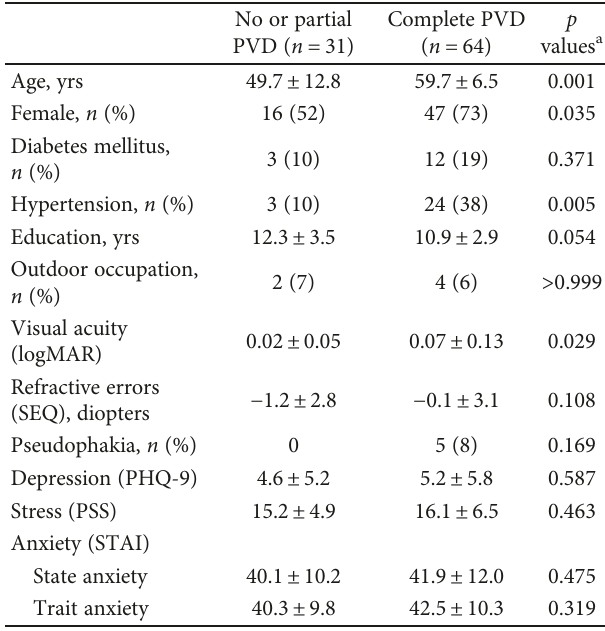
Table 3: Comparison of demographics and psychologic parameters between patients with and without complete posterior vitreous detachment identi fi ed on optical coherence